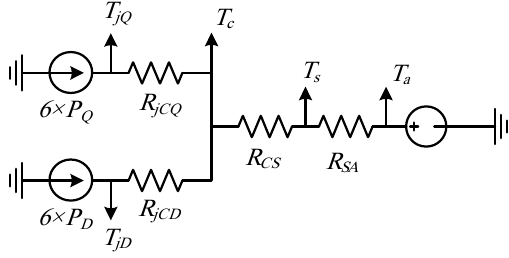
Figure 8. The IGBT power module’s thermal resistance network.